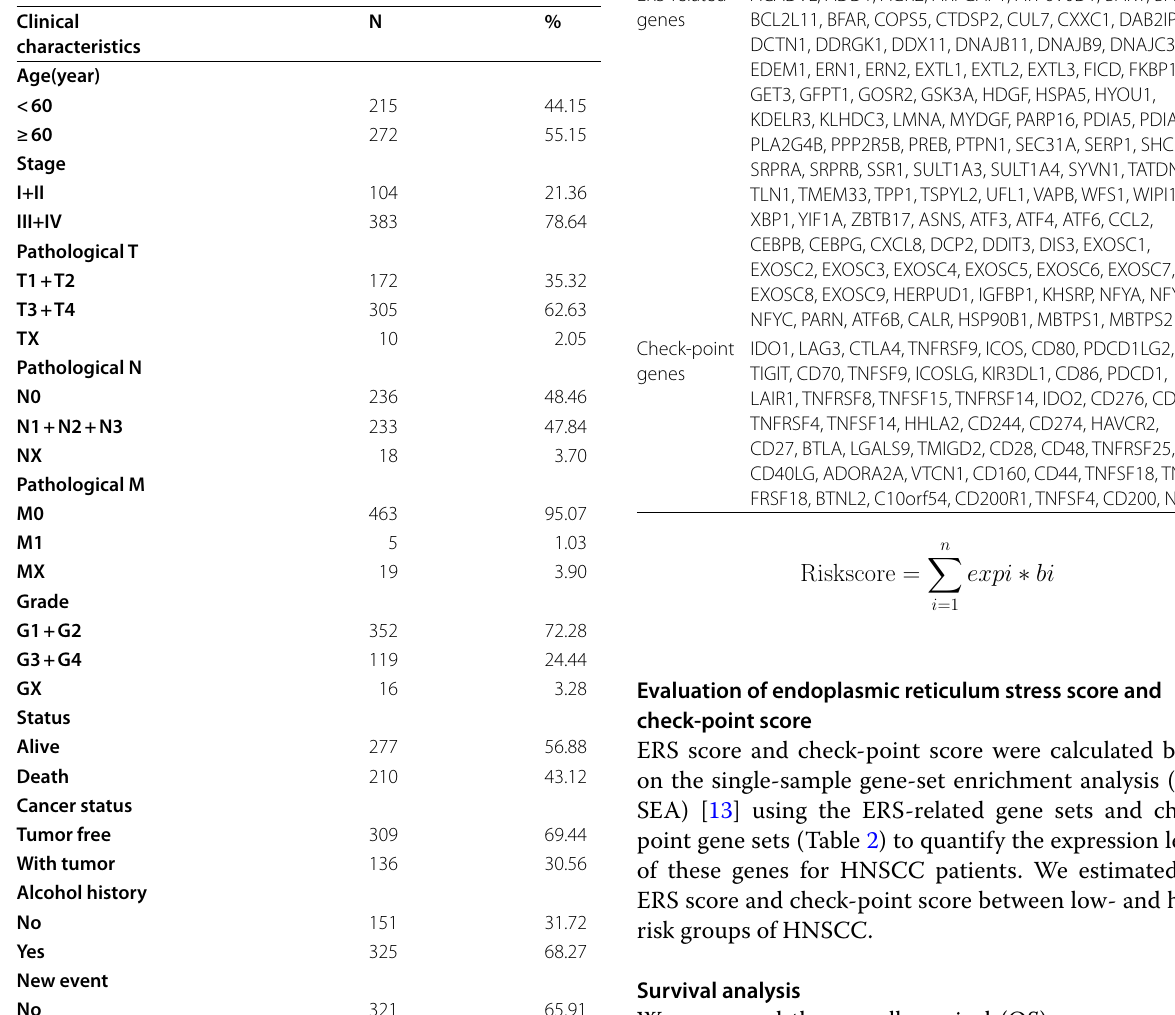
Table 1 Clinical characteristics of HNSCC patients in TCGA database Clinical characteristics